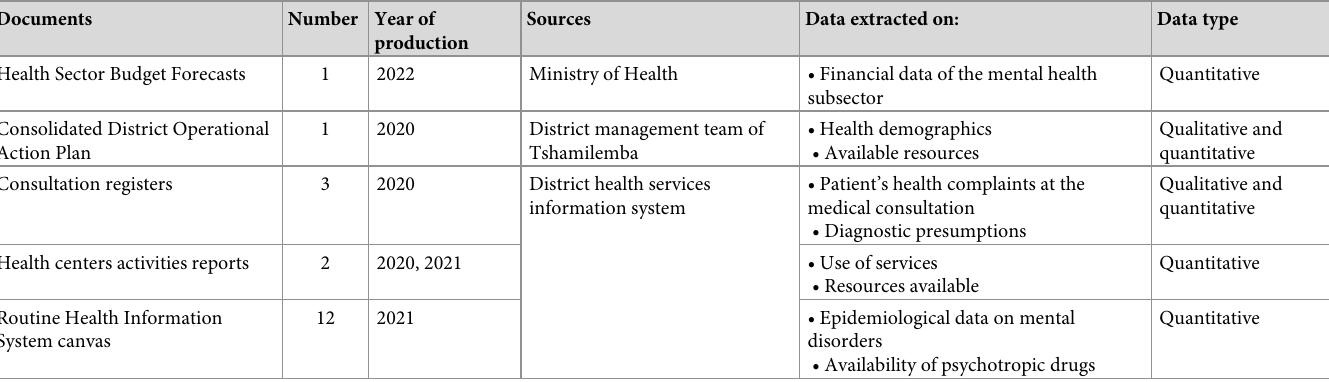
Table 1. Documents consulted and type of data collected.